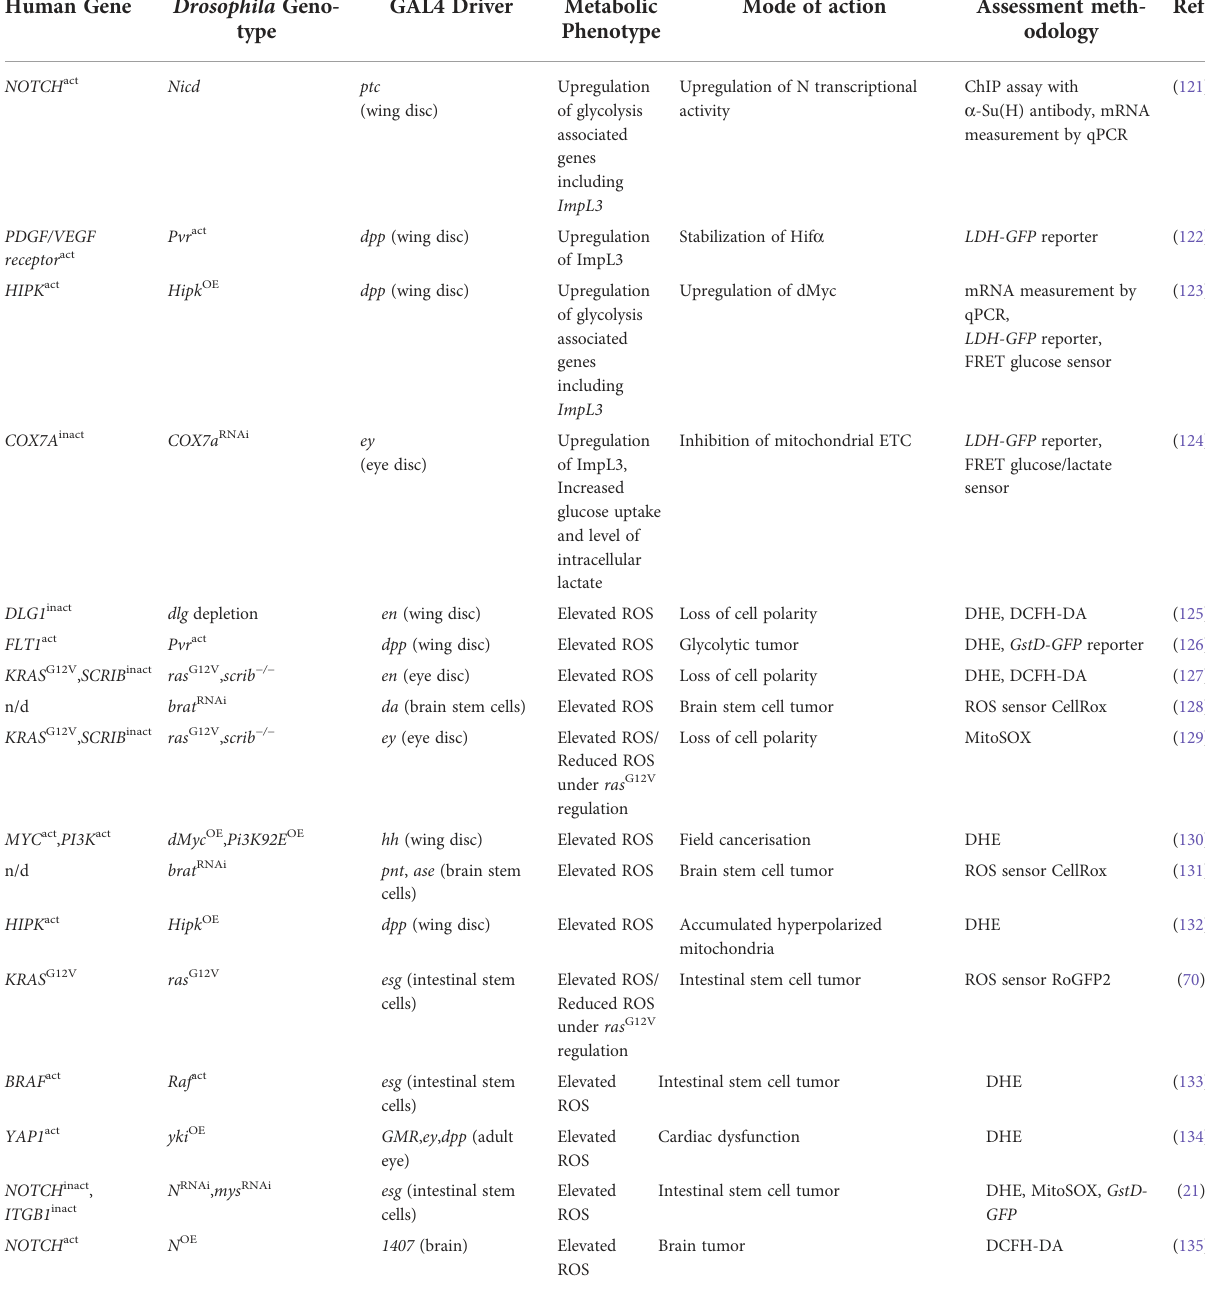
TABLE 2 Drosophila models reproducing cancer